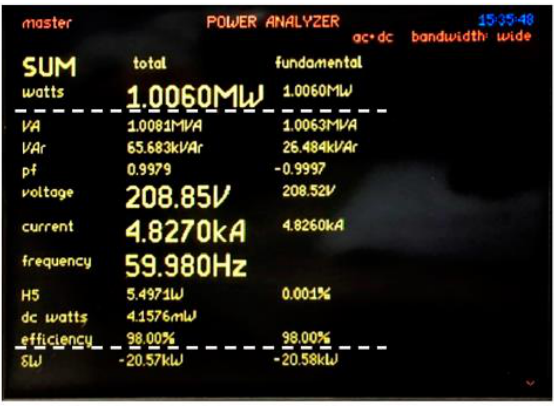
Figure 22. Efficiency measurement result at the 1 MW rated output.